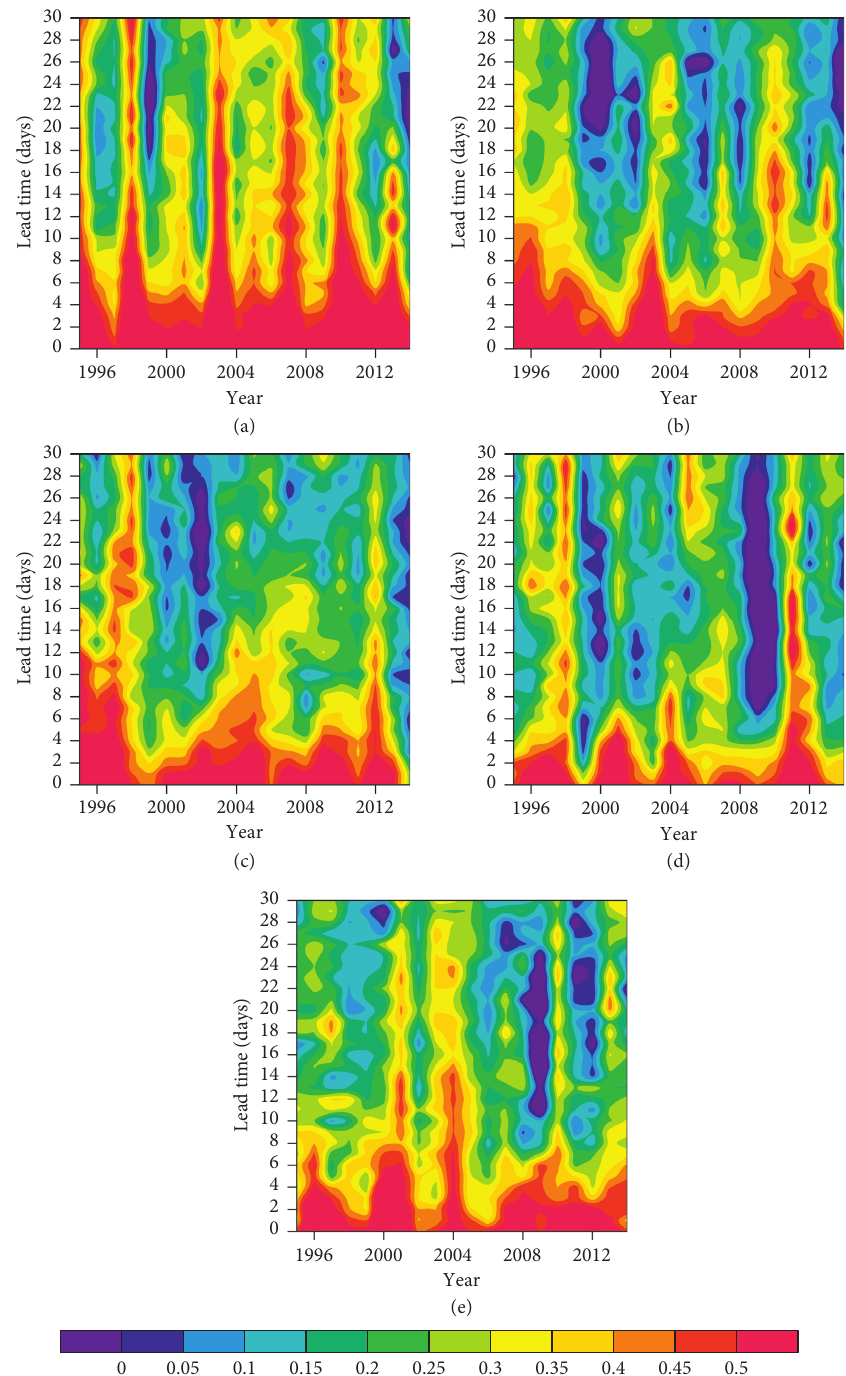
Figure 7: As in Figure 3, but for error-corrected ECMWF hindcast. (a) Reg1, (b) Reg2, (c) Reg3, (d) Reg4, and (e) forecast error. The forecast skill with TCC values of 0.15 ∼ 0.2 Figure 9. From Figure 9, the standardized RMSE values is enhanced (0.25 ∼ 0.3) in Southeast China (Reg1) at lead between the ensemble mean and observed summer accu- times of 20–30 days, while the skill increases least signifi- mulated ten-day precipitation for the ECMWF S2S hindcasts cantly in North China (Reg3) after the forecast error decrease to a certain degree after correcting the hindcast correction. error. This means that the performance of the ECMWF hindcast is improved after correcting the forecast error.